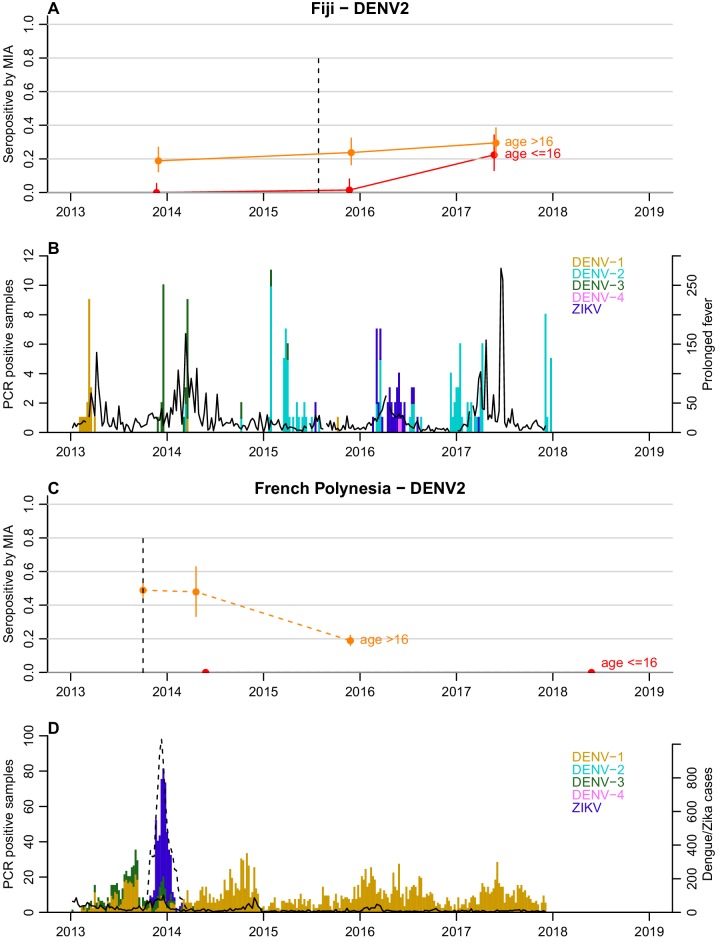
Seroprevalence against DENV-2 in Fiji and French Polynesia, by age group.Figure colour scheme and data characteristics are same as in Figure 1.